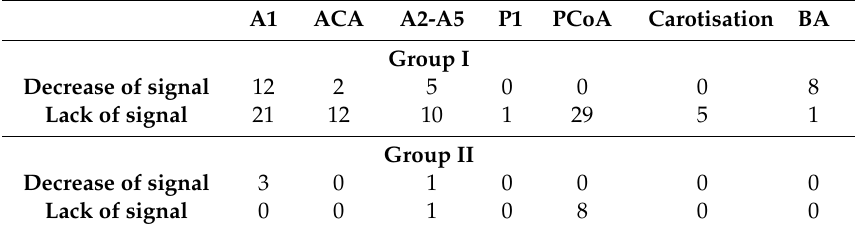
Table 2. Distribution of pathologies in the circle of Willis in Group I and Group II.